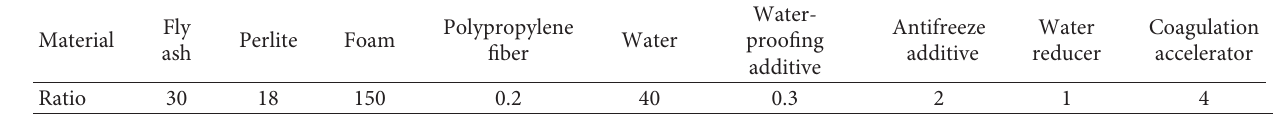
Table 7: Optimum proportion for tunnel antifreeze layer (percentage content) [221].